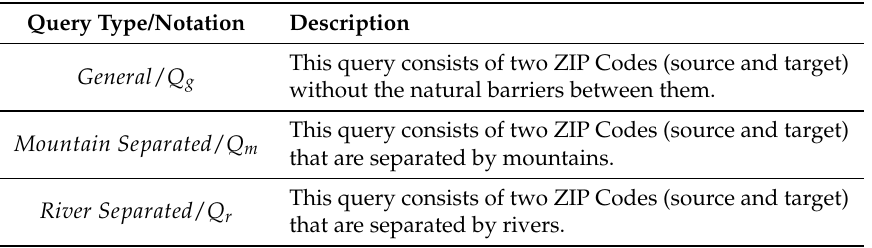
Table 6. Query types based on the natural